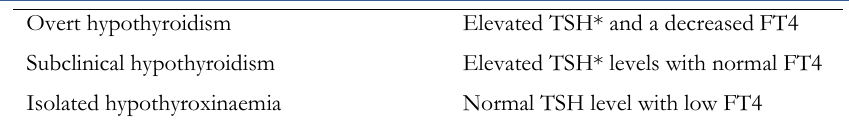
Table 4.3. Diagnosis of hypothyroidism in pregnancy